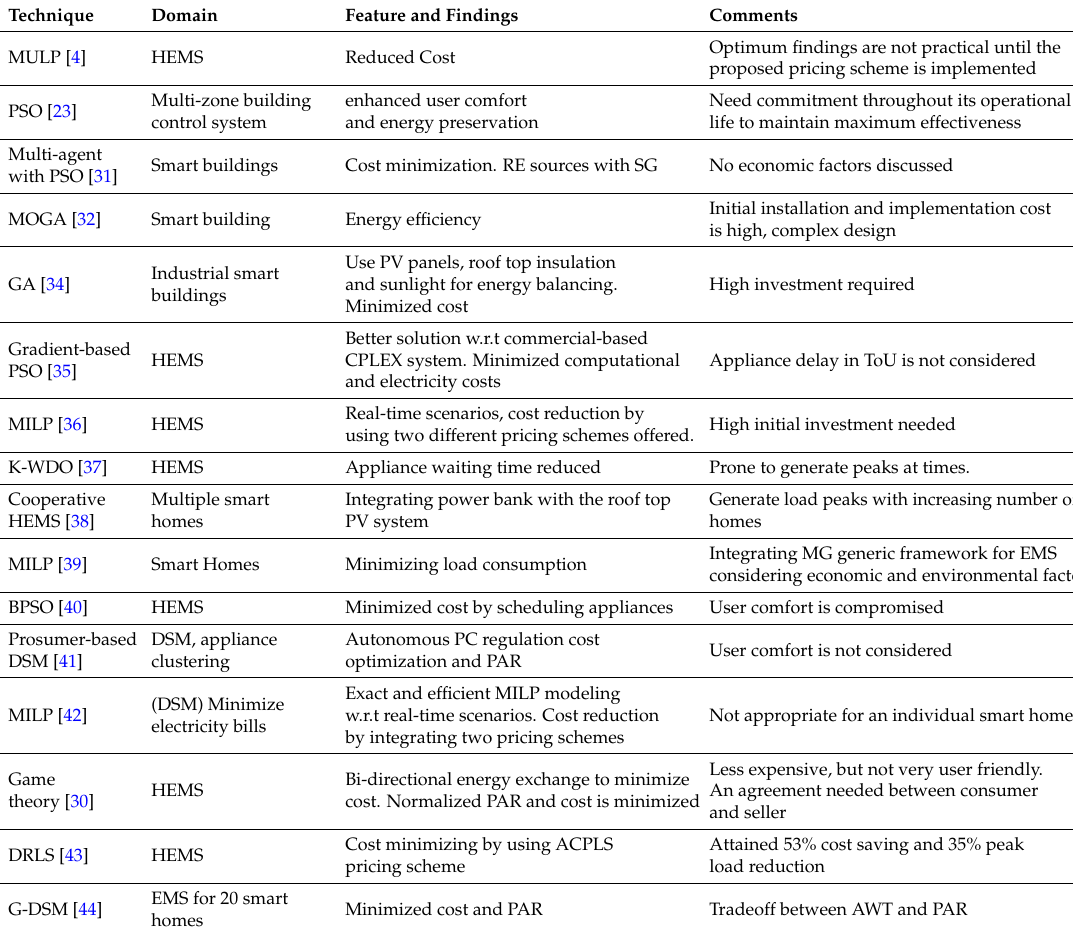
Table 2. Recent trends (EMSs): state of the art